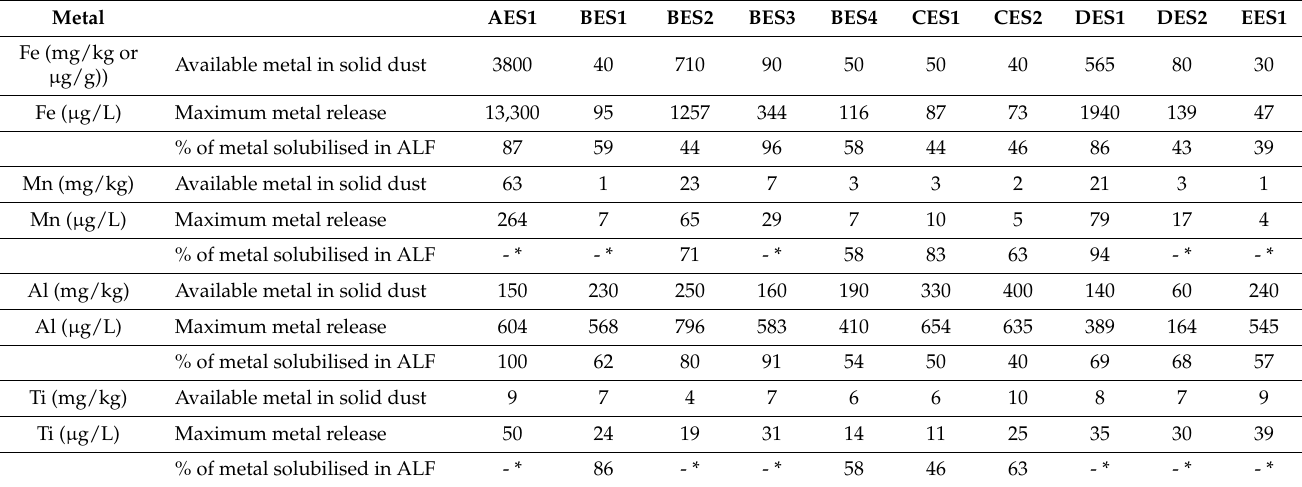
Table 2. Available metal in dust and percentage solubilisation of metals in